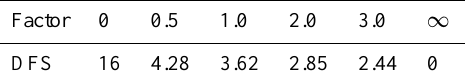
Table 6. GOME-2 DFS dependence on level 1 measurement error multiplied by “Factor”. The values for factors 0 and ∞ are derived from Eq. (3) assuming that S (cid:15) is a diagonal matrix.